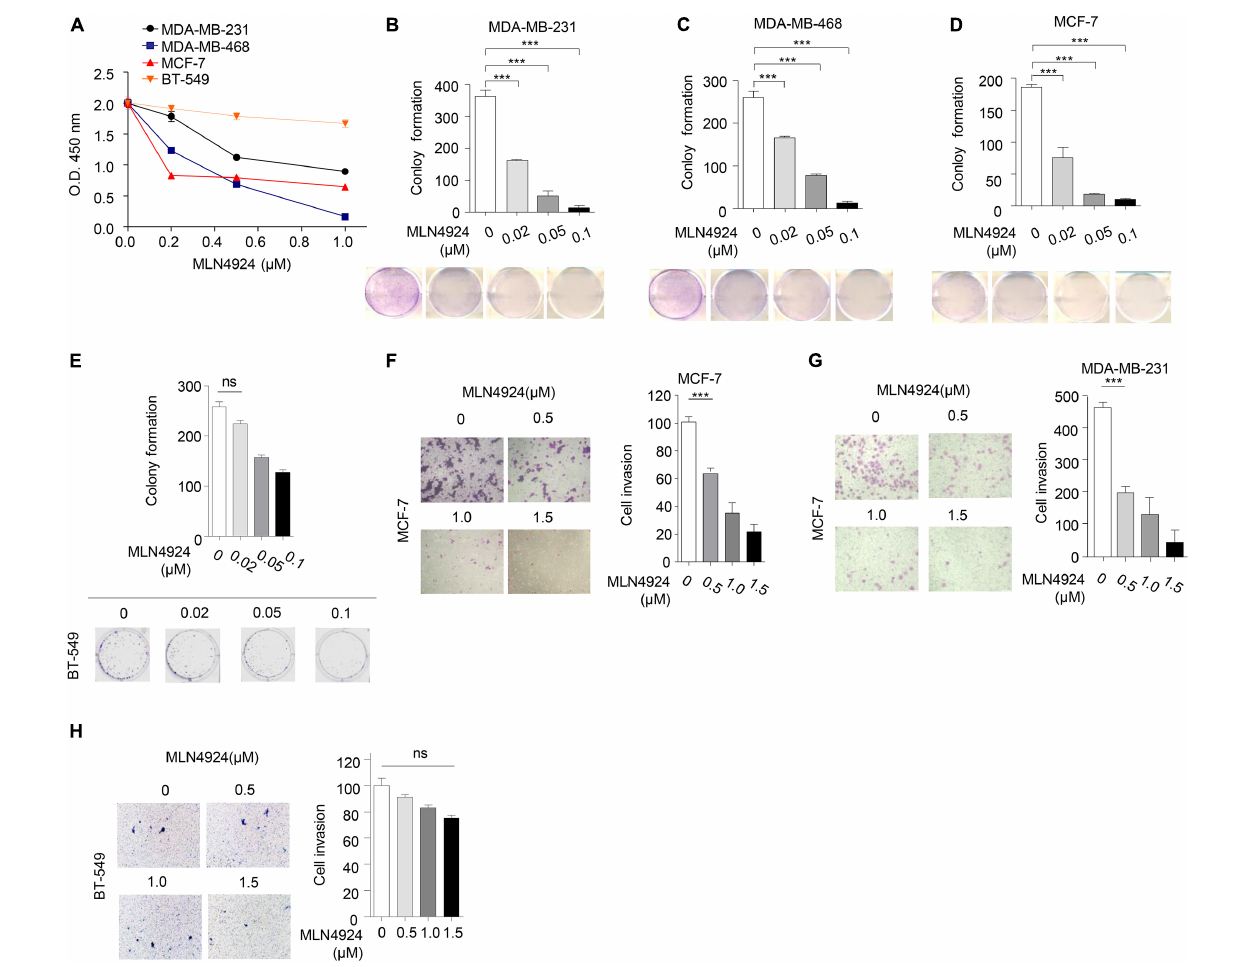
FIGURE 3 | Anti-tumor effect of MLN4924 is dependent on PTEN. (A) Cells were treated with serial dilutions of MLN4924 for 72 h and cell viability was determined using CCK8 assays. Representative inhibitory curves from three independent experiments are shown for each cell line. (B–E) Cells were seeded into 6-well plates petri-dishes at 500 cells per dish in triplicate and treated with MLN4924 for 12 days, followed by 0.01% (w/v) crystal violet staining and colony counting. Representative images of three independent experiments are shown for colony formation. Image J was used to perform quantitative analysis. (F–H) Cells were treated with indicated concentrations of MLN4924 for 12 h before being subjected to trans-well migration analysis. Shown are representative images. Image J was used to perform quantitative analysis. Data are shown as the mean ± SD. P -values were calculated by one-way ANOVA test (B–H) and two-way ANOVA test (A) . * P < 0.05, ** P < 0.01, *** P <